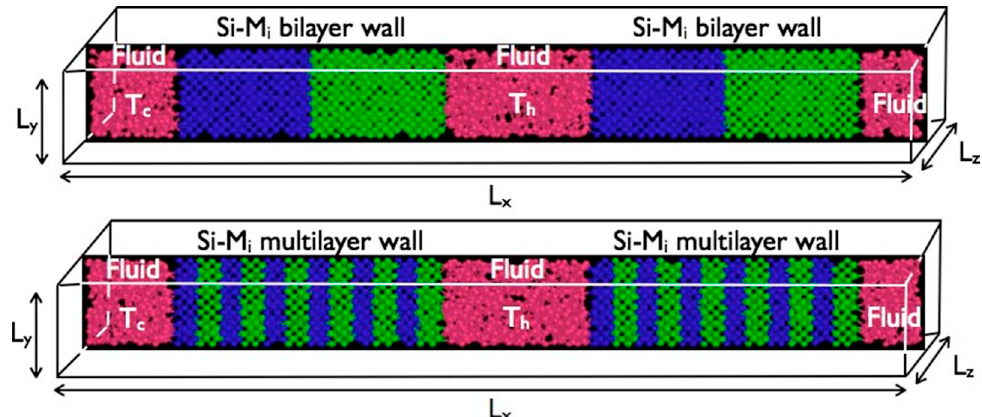
Figure 5. Schematic diagram of a domain based on an arbitrary simulation for systems with bilayer and six-layer composite Si (or M 1 ) -M i superlattice walls. Periodic boundary conditions apply on all six faces of the basic cyclically replicated parallelepiped. The domain dimensions are L x = 20.99 nm and L y = L z = 2.172 nm. Reproduced with permission from [46], Copyright AIP Publishing, 2019.